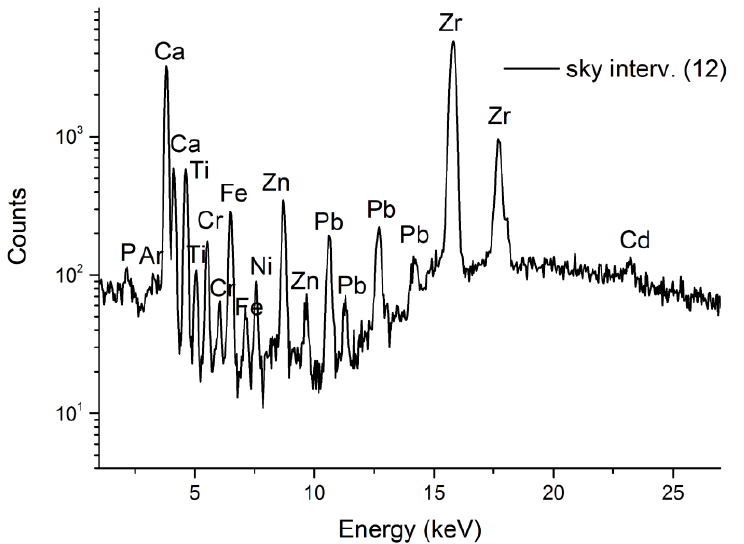
Figure 9. XRF spectrum of a retouched area in the sky, revealing the use of a calcium-based filler (probably gypsum), overpainted with modern pigments, zinc (Zn) and titanium (Ti) whites, chrome green (Cr), and cadmium yellow (Cd).